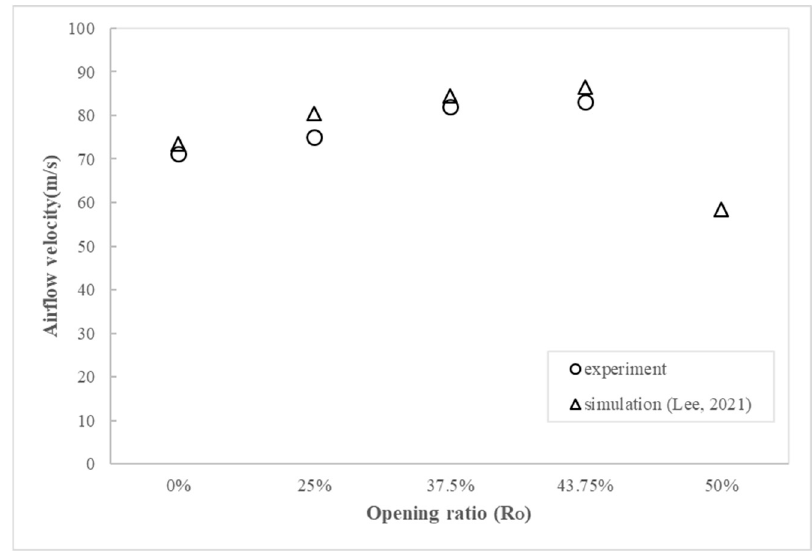
Figure 21. Comparison of the velocity of air flow from the OWC with various opening ratios.